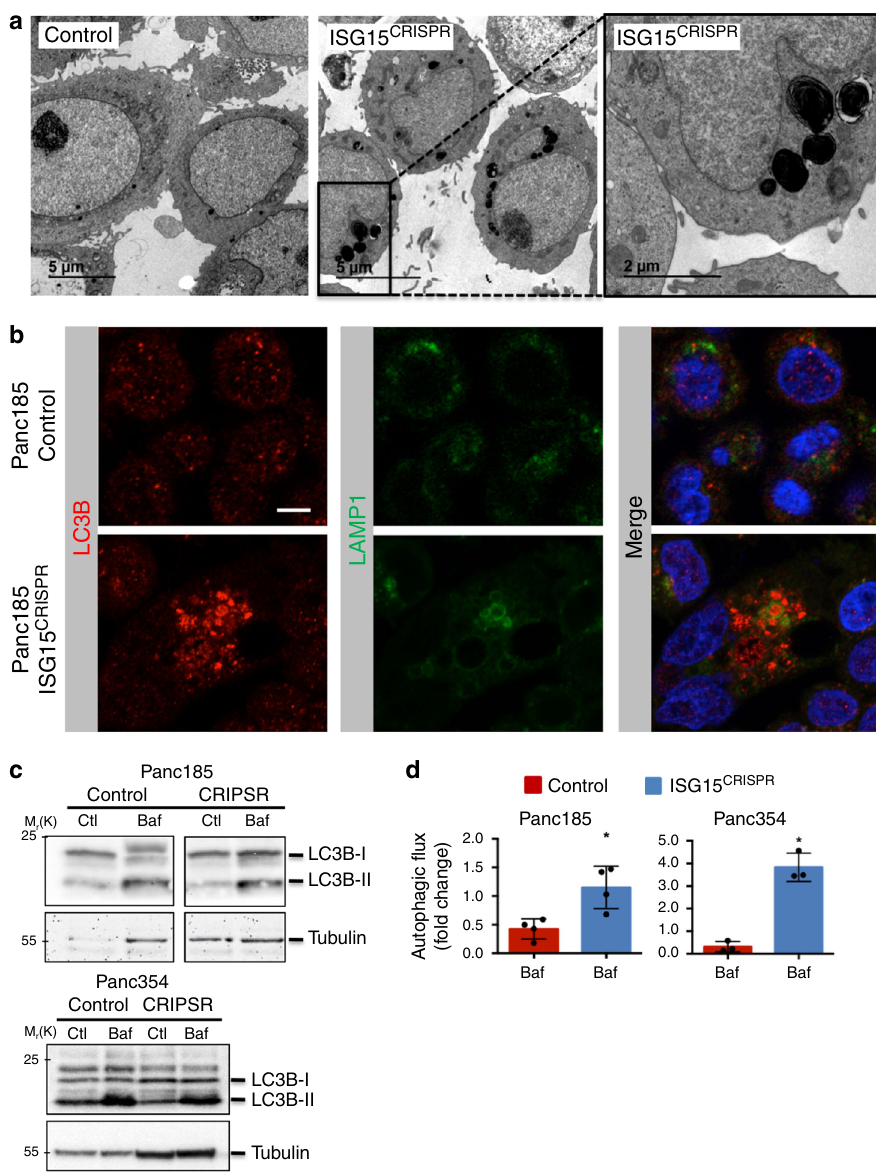
Fig. 6 Autophagosomes and autophagic fl ux increase in the absence of ISG15/ISGylation. a Transmission electron micrographs of control and ISG15 CRISPR Panc185 cells. Scale bars = 5 or 2 µ M. b Immuno fl uorescent images of LC3B (red) and LAMP1 (green) in control and ISG15 CRISPR Panc185 cells. Nuclei stained with DAPI in blue. Scale bar = 10 µ M. c WB analysis of LC3B in control and ISG15 CRISPR cultures untreated (Ctl) or treated with the autophagy inhibitor Ba fi lomycin (Baf) for 5 h. Tubulin was used as loading control. d Mean fold change ± sd in autophagic fl ux determined by densitometric quanti fi cation of LC3B-II accumulation after autophagy inhibitor addition, subtracting their respective control expression levels (Panc185: n = 4 independent experiments; * p = 0.0162, as determined by Student ’ s t -test; and Panc354: n = 3 independent experiments; * p = 0.0143, as determined by Student ’ s t